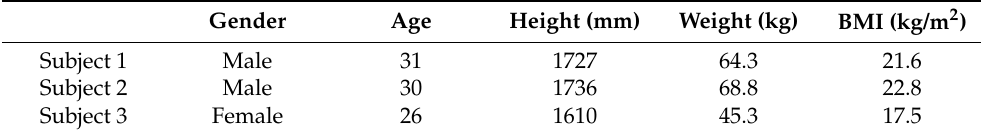
Table 4. The subjects.